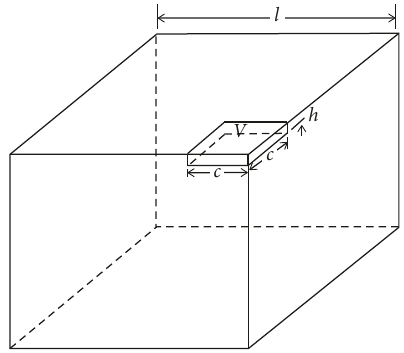
Figure 2: Schematic diagram of the volume of debris removed from the crystal